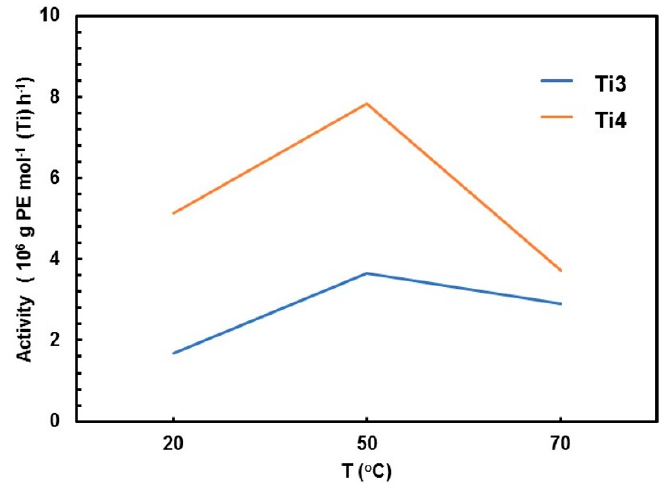
Figure 7. Ethylene polymerization results at various temperatures by Ti3 and Ti4